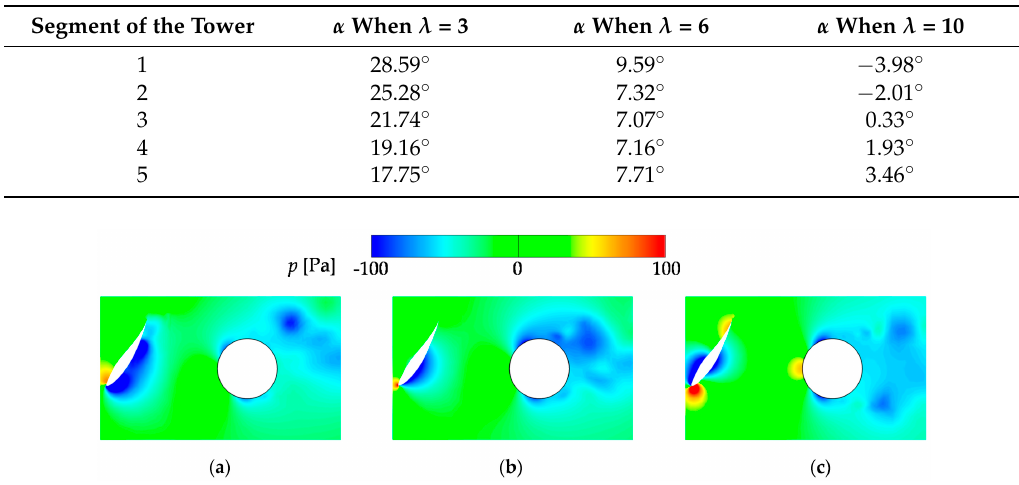
Table 2. Angle of attack of the blade at Ψ = 0 ◦ at the mid-height of each tower segment. Segment of the Tower